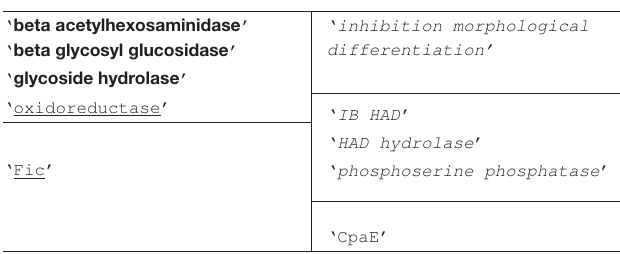
TABLE 2 | Synteny phrases for linguistic search after 1st update using synteny annotations of Streptomyces Ms1 RNA homologs ( Supplementary Figure 2 ). For description of the table, see legend of Table 1 .